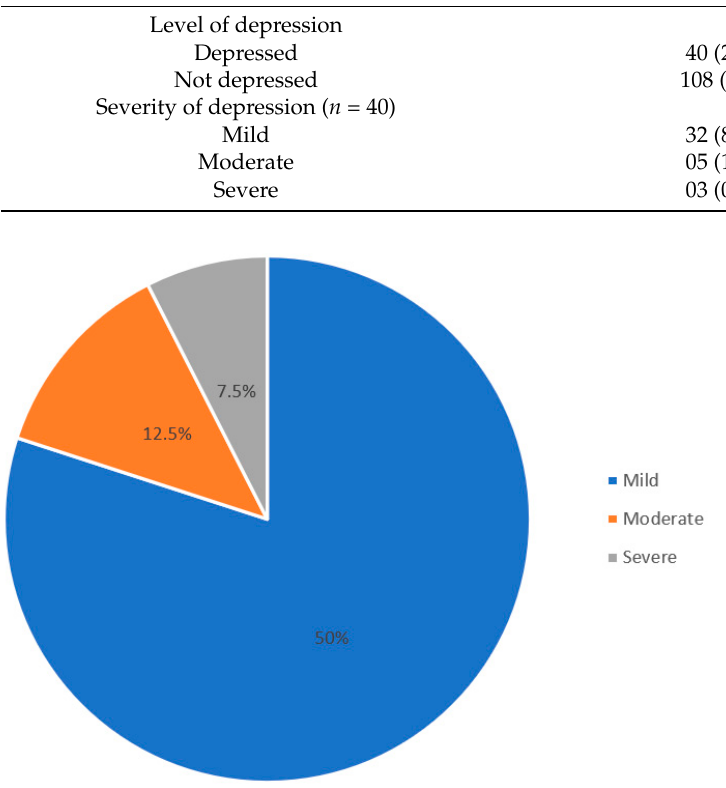
Figure 1. Proportion of patients based on severity of depression.